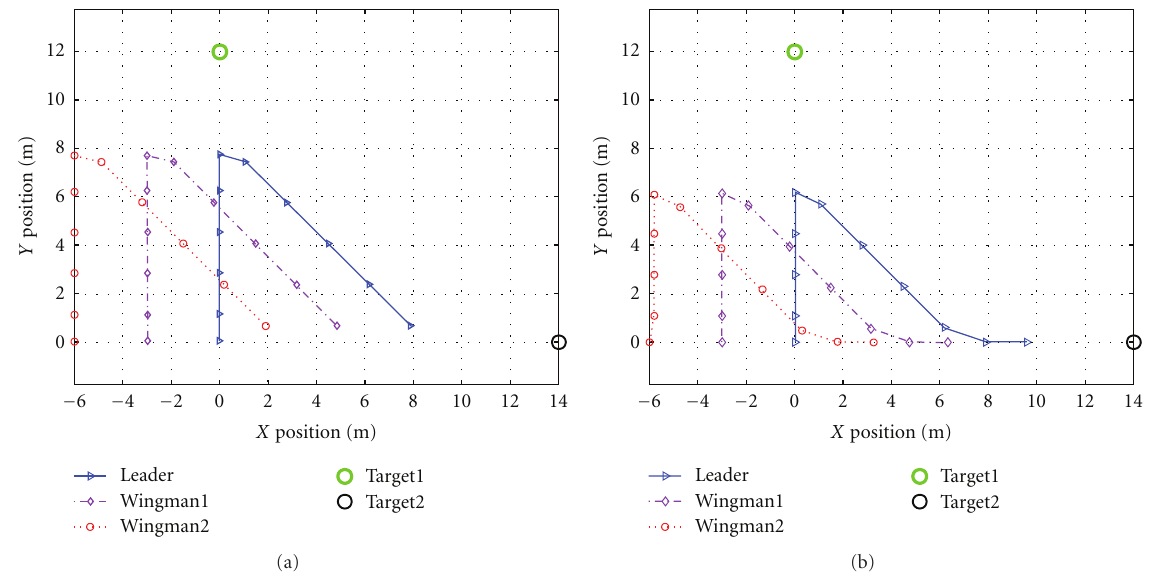
Figure 11: Multiplexed decentralized versus nominal decentralized scheme. (a) Nominal decentralized formation. (b) Multiplexed decentralized formation.